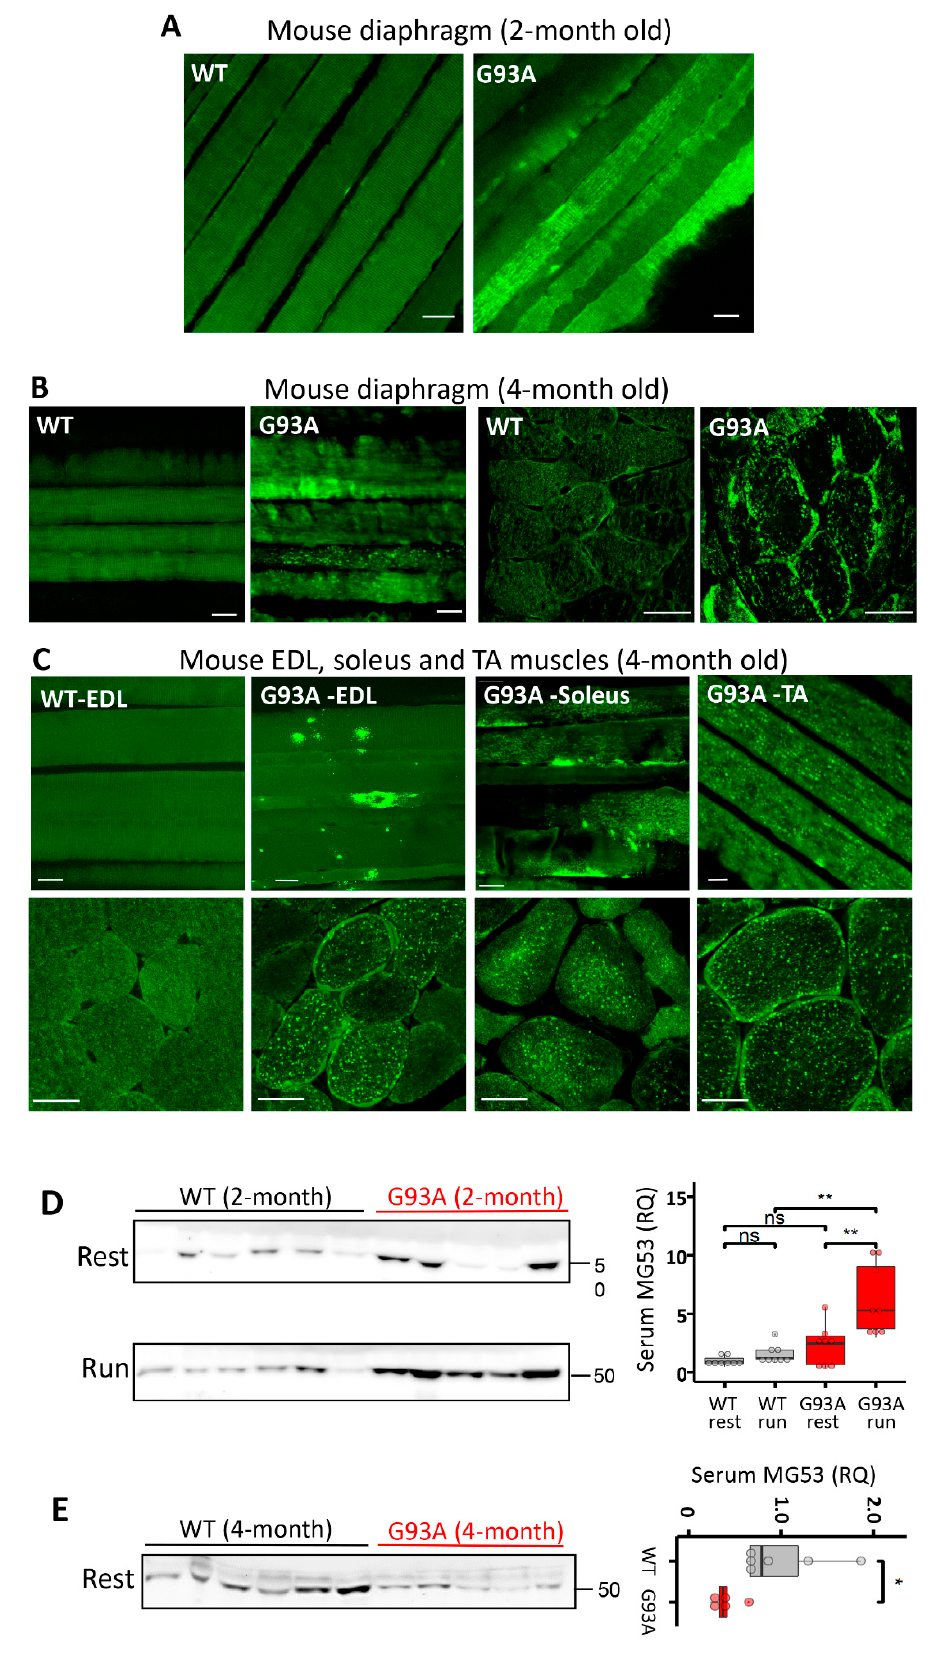
Figure 2. MG53 is implicated in the membrane fragility of G93A diaphragm, fast- and slow-type muscles. ( A ) MG53 immunostaining of diaphragm muscle of WT and G93A mice after the 30 min